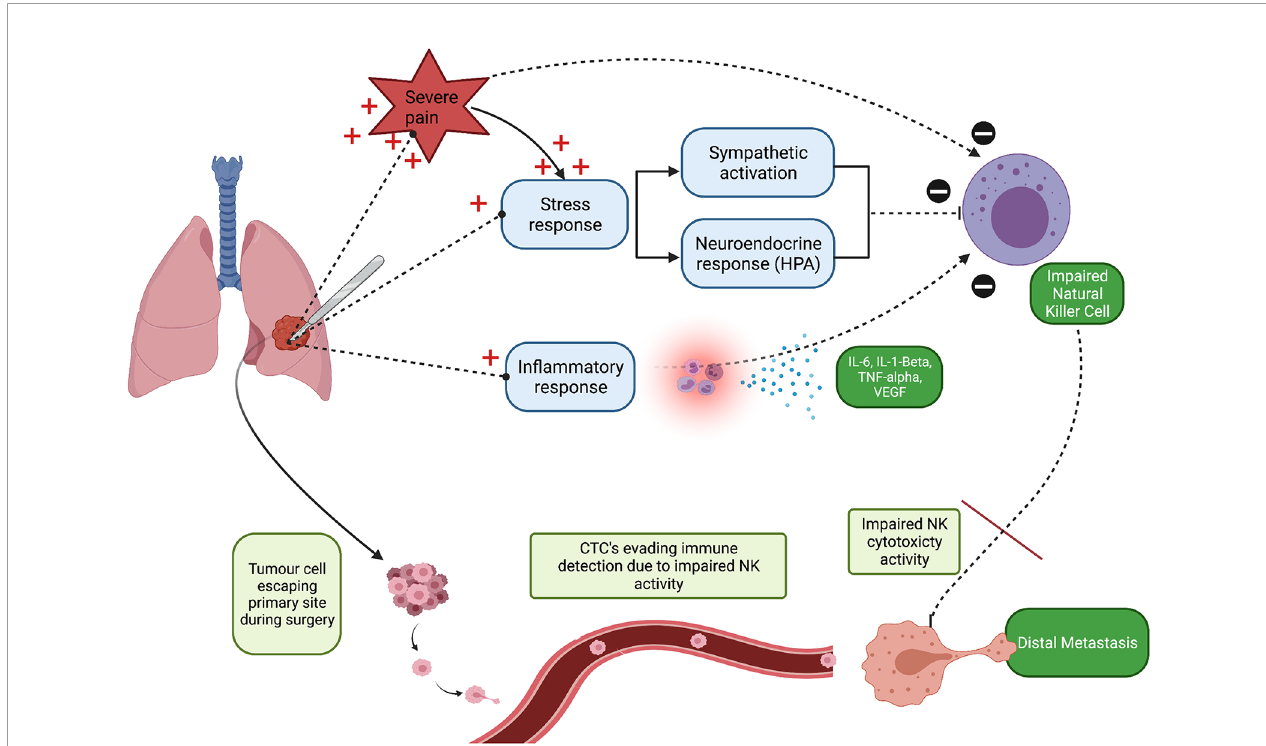
FIGURE 1 | Schematic illustration highlighting that poorly controlled acute perioperative pain may promote tumour cell seeding and consequently increase the risk of distal metastasis. NK, Natural Killer cell; CTCs, Circulating Tumour Cell ’ s. Created with